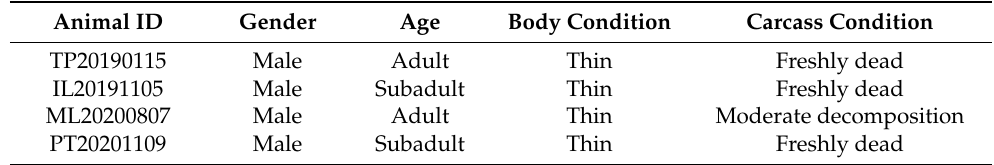
Table 1. The details of sampled dolphins in the current